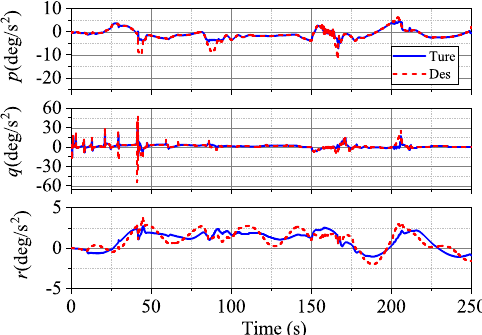
Figure 10. Results for p , q , and r in persence of disturbances.